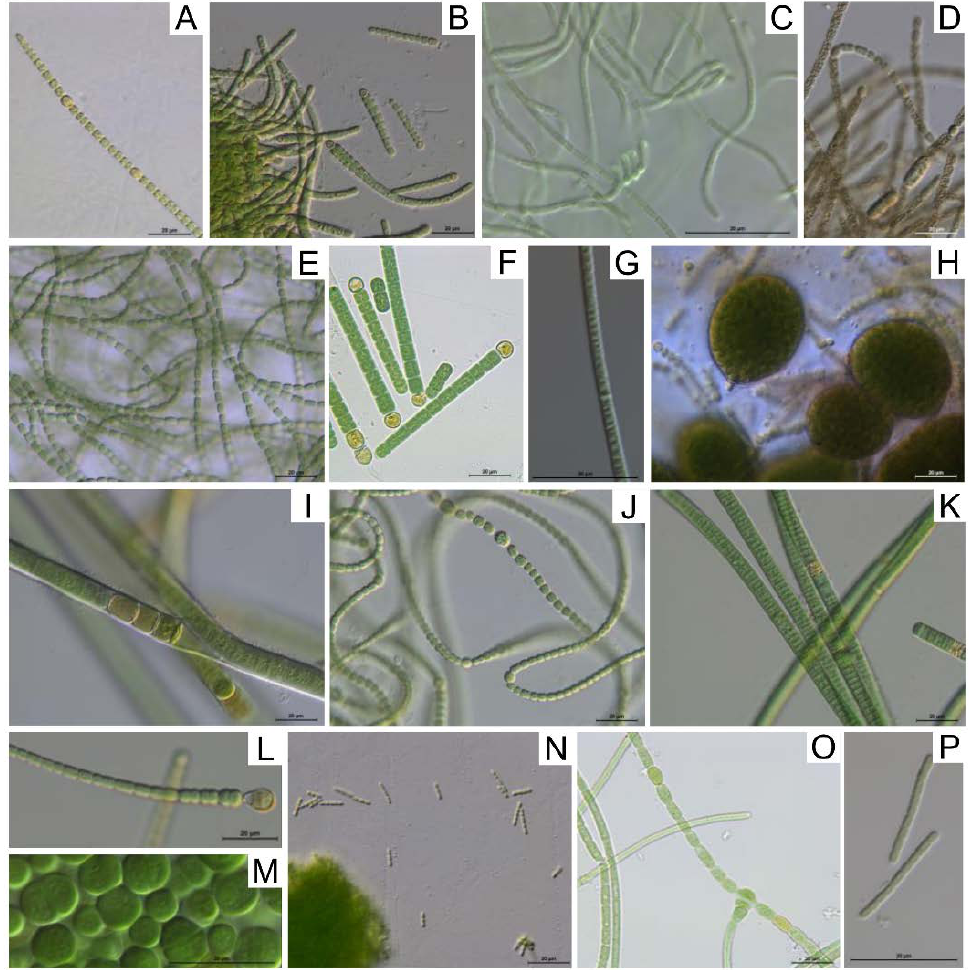
Figure 1. Selected strains photomicrographs of cyanobacteria from the Azores islands. ( A ) Anabaena